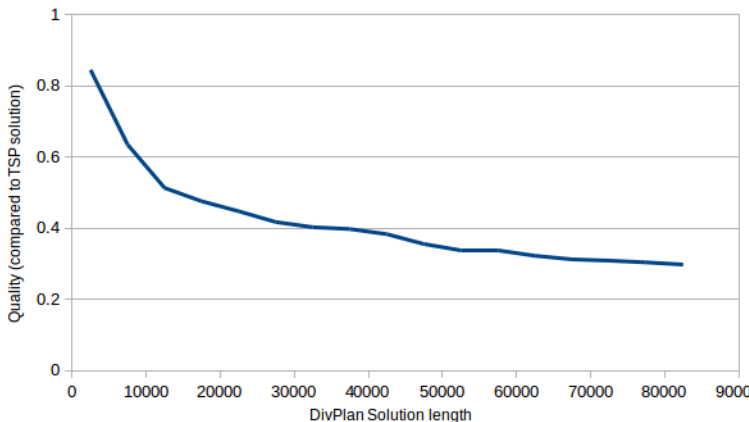
Figure 3. Comparison of DivPlan solution with the optimal solution of “omnipotent UAV” covering the same sensor tasks. We can see that the DivPlan solution was in average at most three times longer even for the longest solutions of scenarios with several dozens of